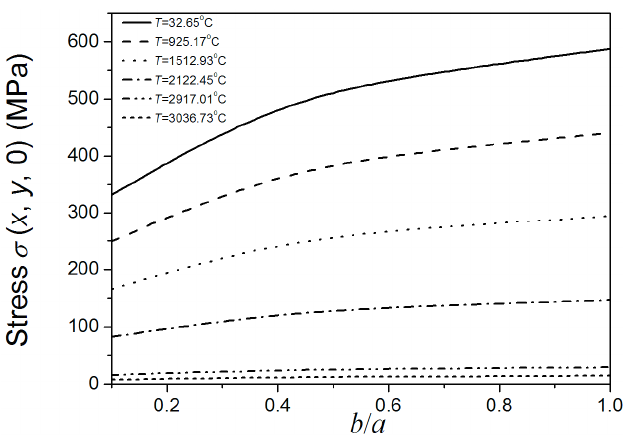
Figure 5. b / a ratio dependence of the highest σ ( x , y , 0) on the crack edge under different temperatures ( a is a definite value).